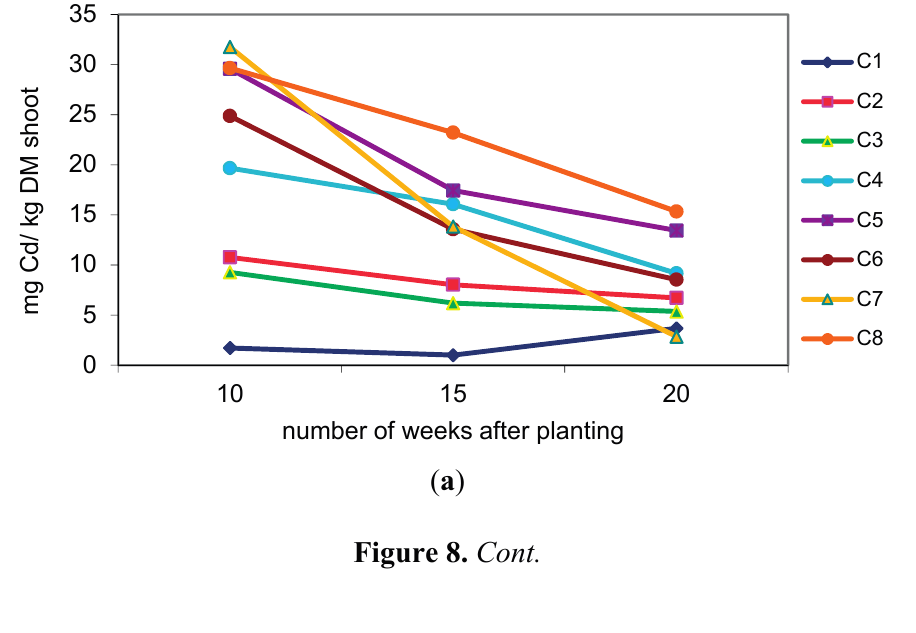
number of weeks after